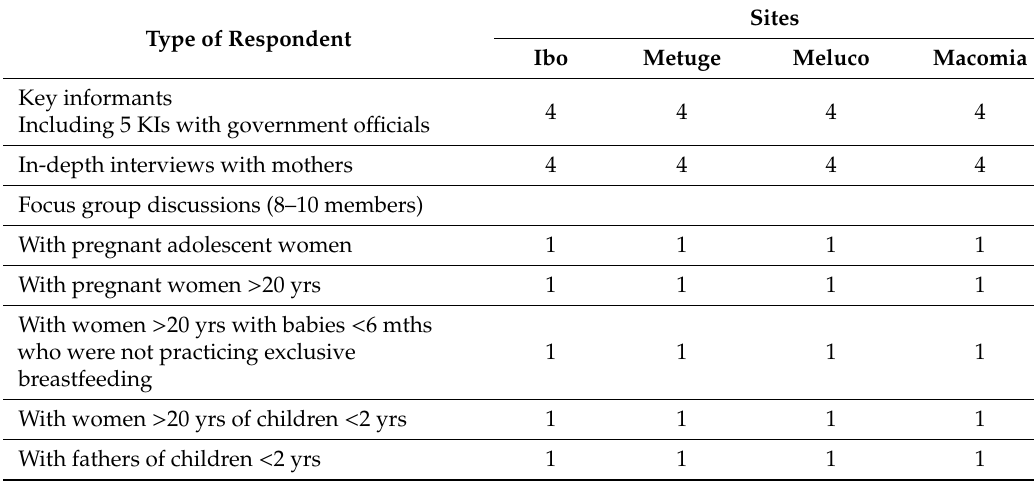
Table 1. Study population and segmentation by